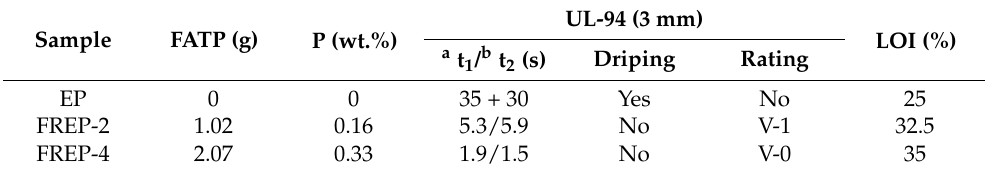
Table 3. UL-94 rating and LOI values of the FREPs.